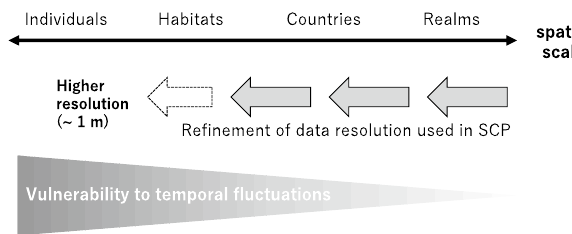
Fig. 1 Improvement of data resolution used in spatial conservation planning (SCP), and the potential impact of temporal change on